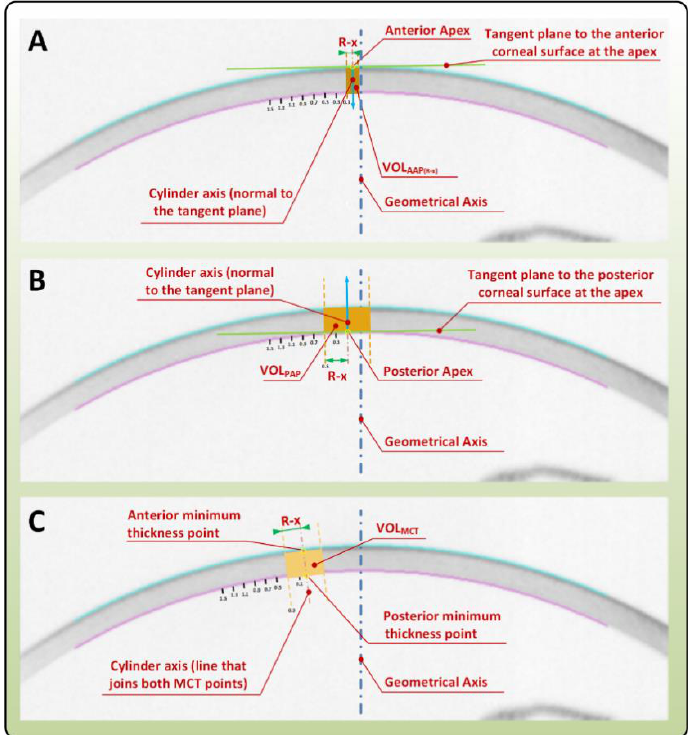
Figure 2. Calculation of VOL AAP , VOL PAP , and VOL MCT as the intersection between the corneal model and different cylinders of revolution with variable radius, and their axes defined as: ( A ) VOL AAP is a straight line perpendicular to the tangent plane to the anterior corneal surface at the apex (R = 0.1 mm shown); ( B ) VOL PAP is a straight line perpendicular to the tangent plane to the posterior corneal surface at the apex (R = 0.5 mm shown), ( C ) VOL MCT is the points of the minimum corneal thickness of the anterior and posterior corneal surface (R = 0.3 mm shown).